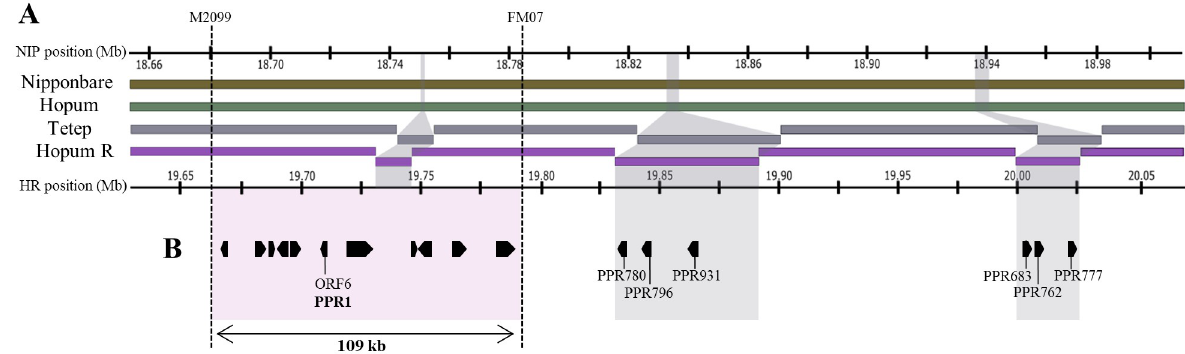
Fig 5. Synteny and gene annotation within the candidate region. (A) Multiple sequence alignment of Nipponbare, Hopum, Tetep and Hopum R using MAUVE. (B) Illustration of 11 candidate genes annotated within the 109 kb candidate region (red portion), and PPR genes annotated from Tetep-specific insertions (grey